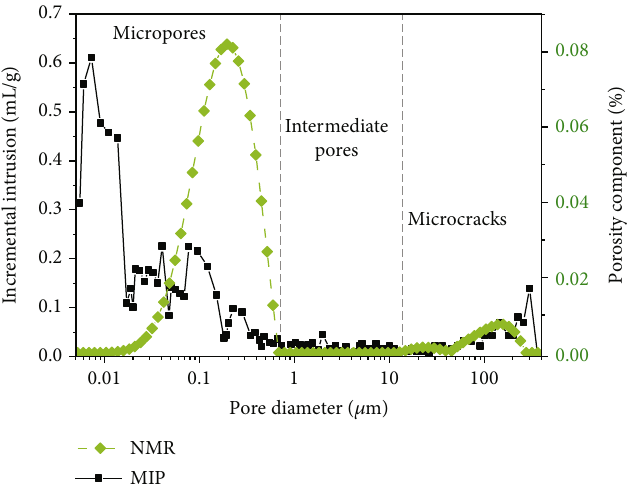
Figure 11: The PSD from the NMR and